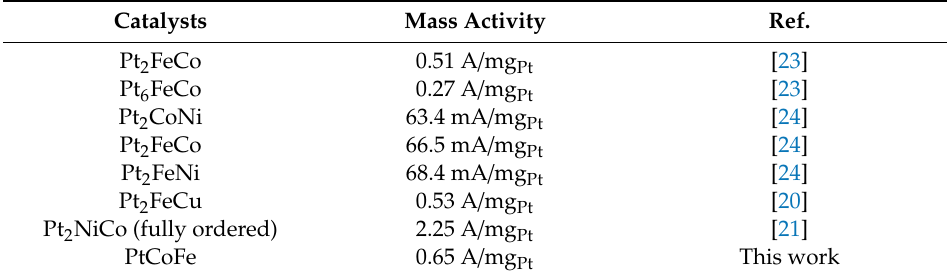
Figure 4. The electrochemical testing results of ternary alloys annealed at 400 and 600 ◦ C. ( a ) The CV curves of PtMN-H600; ( b – d ) LSV profiles of PtNiCo, PtCoFe, and PtFeNi, respectively; ( e ) the column figure of mass activities of ternary alloys and Pt / C; ( f ) the comparison of the stability of disordered and ordered PtCoFe. Table 1. Comparison of mass activities of reported Pt ternary intermetallics and the ordered PtCoFe in this